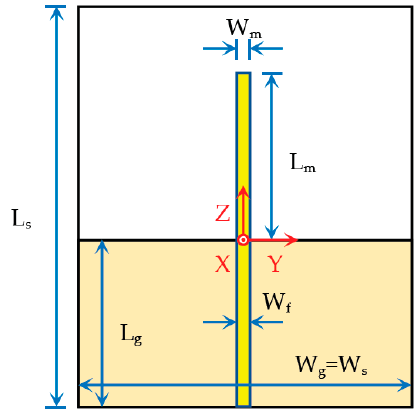
Figure 1. Printed planar straight monopole configuration.